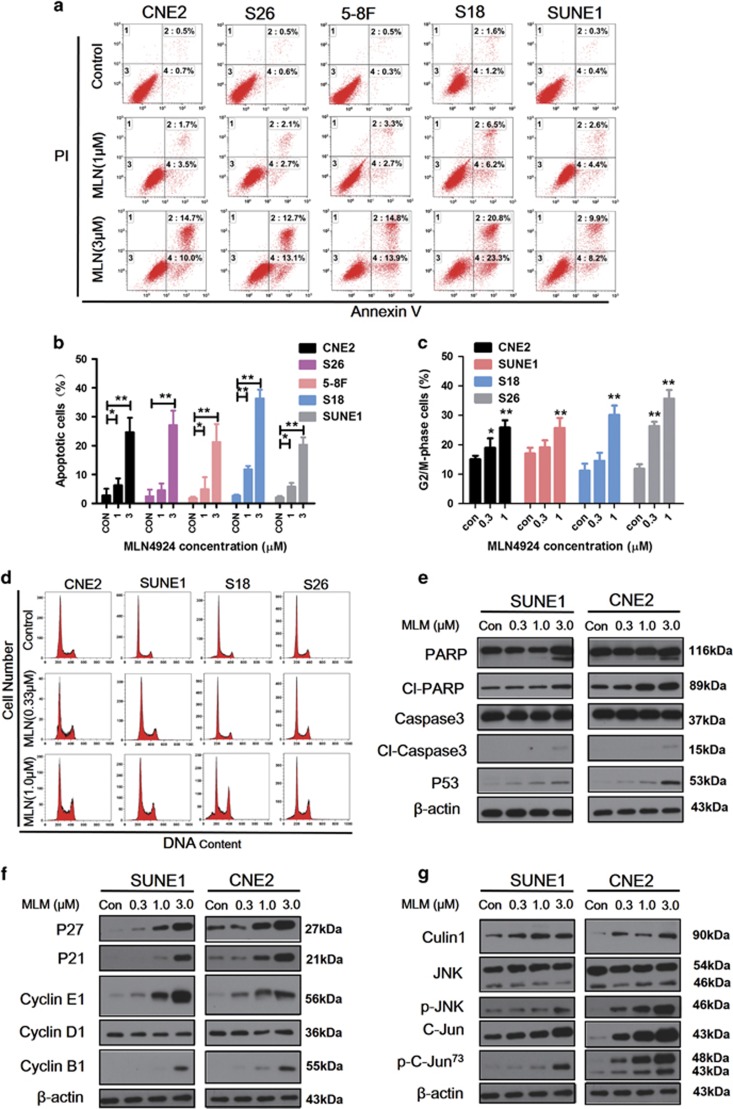
Effects of MLN4924 on apoptosis and cell cycle progression in human NPC cell lines. (a,b) CNE2, S18, S26, 5-8Fand SUNE1 were treated with MLN4924 at 1 μM and 3 μM for 48 h, followed by FACS for apoptosis analysis. (c,d) The given cell lines were exposed to the indicated concentrations of MLN4924 48 h and then harvested for cell cycle profiling. (e–g) CNE2 and SUNE1 were lysed after MLN4924 treatment for 48 h, and western blot analysis to evaluate the expression of protein and β-actin as a loading control. Data are presented as means ±S.E.M. of three independent experiments. *P<0.05, **P<0.01 as compared with the controls